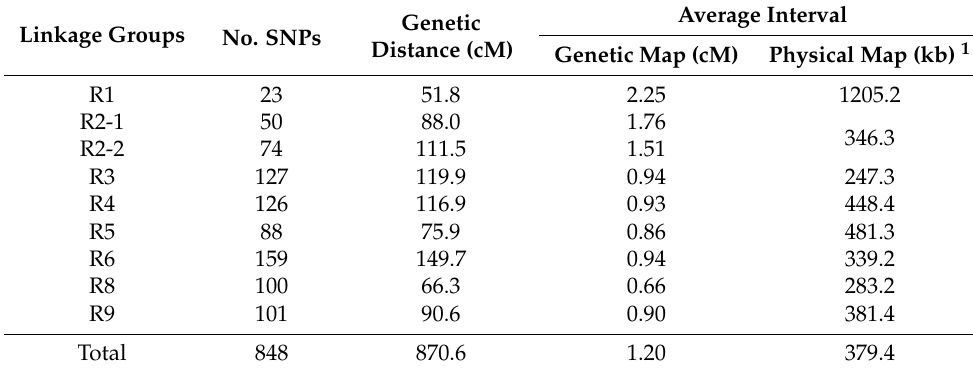
Table 1. The number of single nucleotide polymorphisms (SNPs), genetic distance and average intervals of nine radish linkage groups.